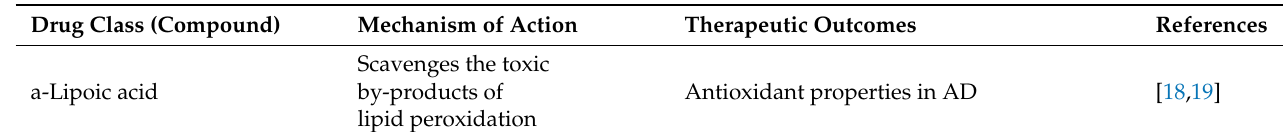
Table 1. Antioxidant and mitochondrially targeted neuroprotective drugs in different neuropatholog- ical